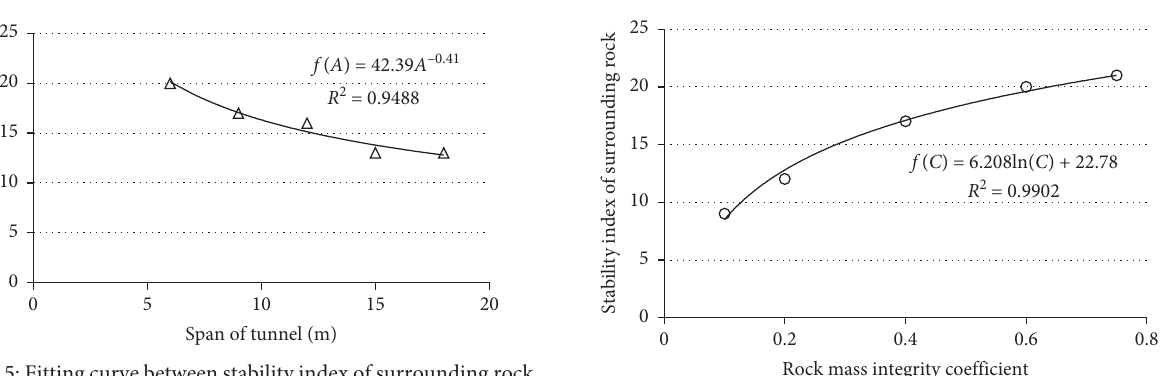
Figure 7: Fitting curve between stability index of surrounding rock and rock mass integrity